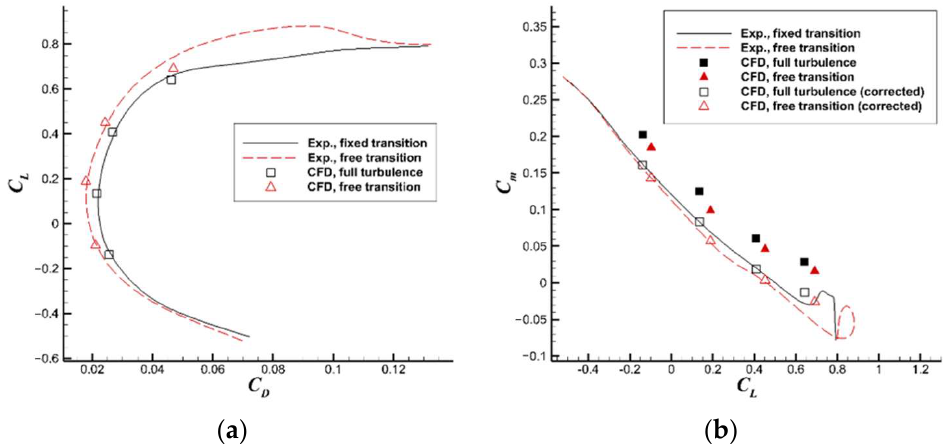
Figure 5. Aerodynamic characteristics by CFD and wind tunnel test. ( a ) C L – C D ; ( b ) C m – C L .